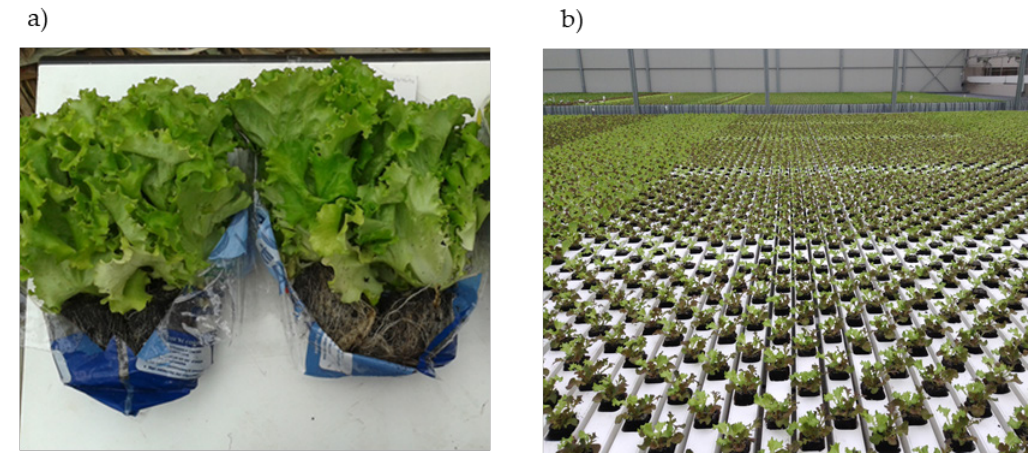
Figure 1. Lettuce triple pack ( a ) and modified intermittent NFT system for soilless lettuce production at Sempre Fresco ® greenhouse ( b ).